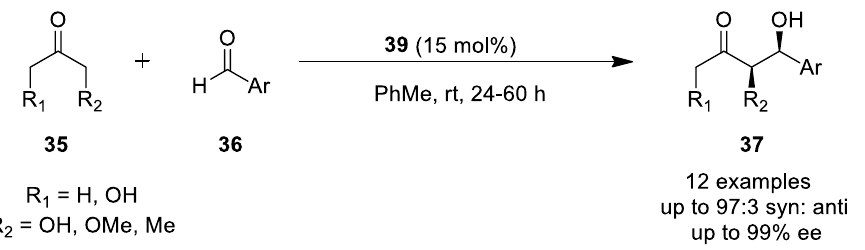
Scheme 17. Efficiency of catalyst 39 in aldol reaction.